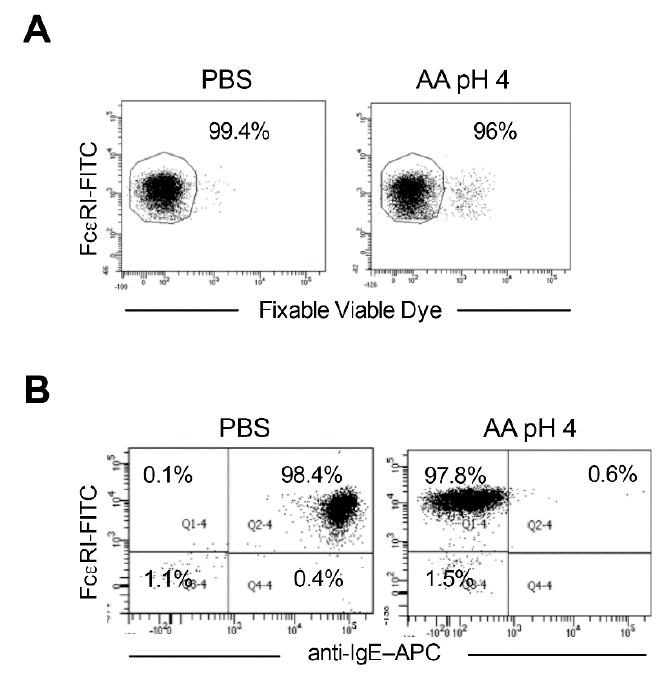
Figure 2. Stripping of surface IgE antibodies bound to Fc ε RI of basophils by acetic acid buffer (pH 4). Basophils were incubated on ice for 5 min either with phosphate buffered saline (PBS) or ice-cold acetic acid buffer pH 4 (0.05 M acetate, 0.085 M NaCl, 0.01 M EDTA and 0.03% human serum albumin) (AA pH 4). Cells were then washed and proceeded with phenotype analyses by flow cytometry. ( A ) The viability of cells immediately following AA pH 4 treatment as analyzed by fixable viable dye staining. ( B ) Efficacy of stripping of basophil surface-bound IgE by AA pH 4 (right panel) as analyzed by surface staining of IgE and analyses by flow cytometry. Representative data from four donors are presented.